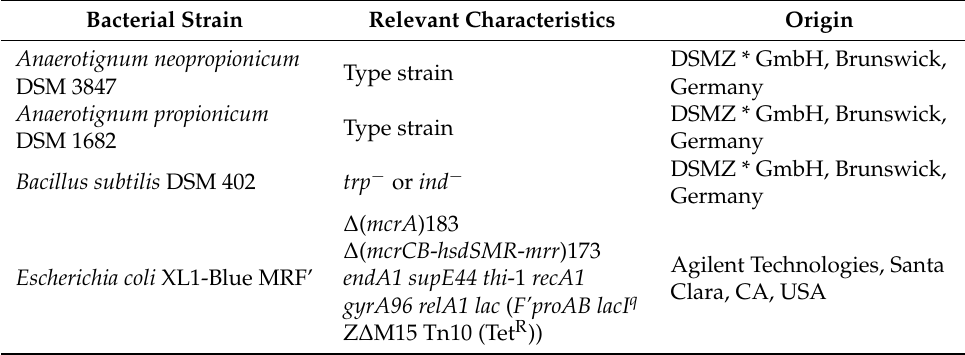
Table 1. Bacterial strains used in this